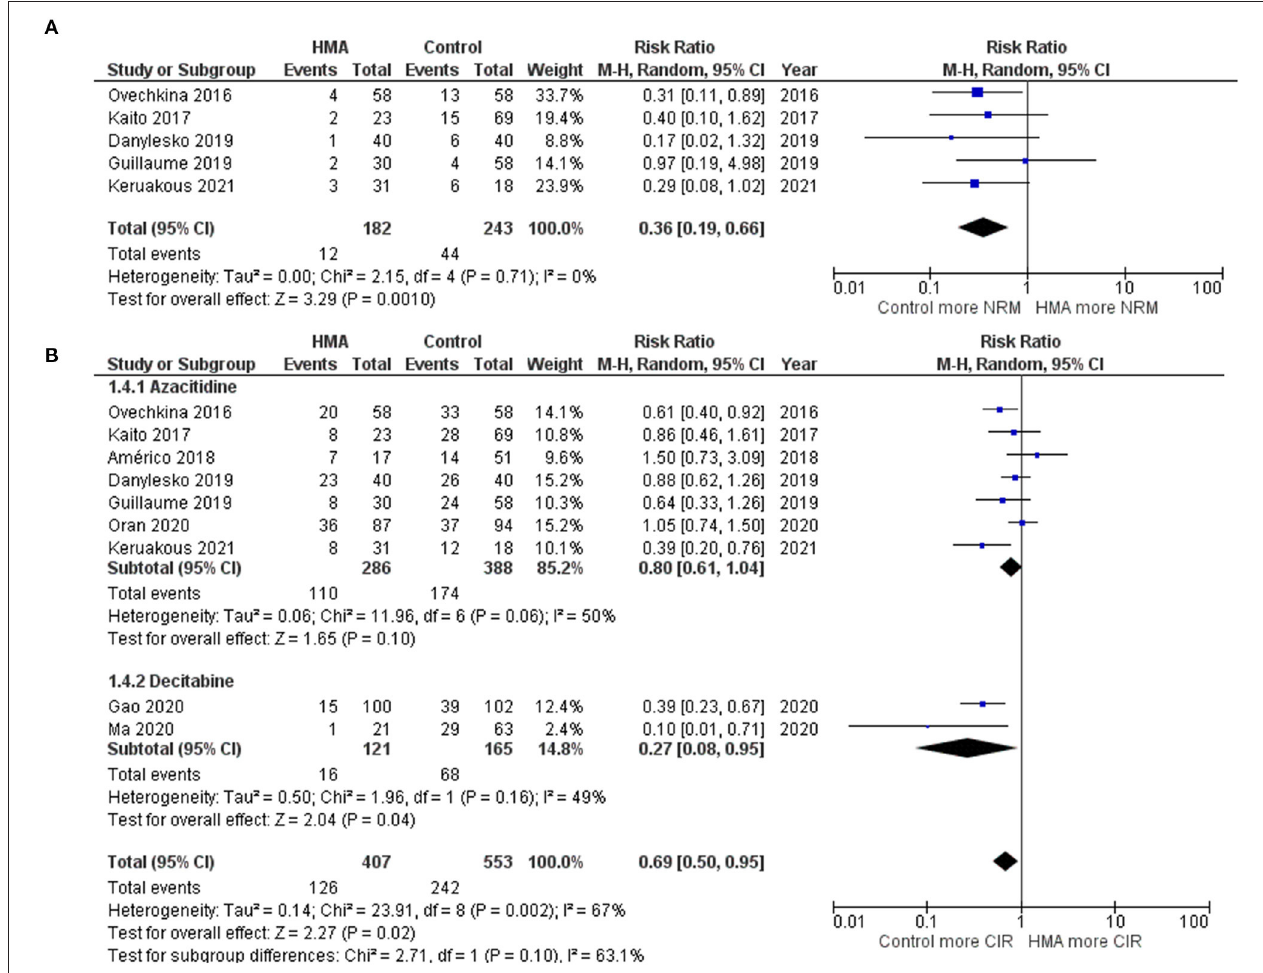
FIGURE 3 | Forest plots of the meta-analysis of HMA maintenance compared with no HMA maintenance. (A) NRM rate. (B) CIR